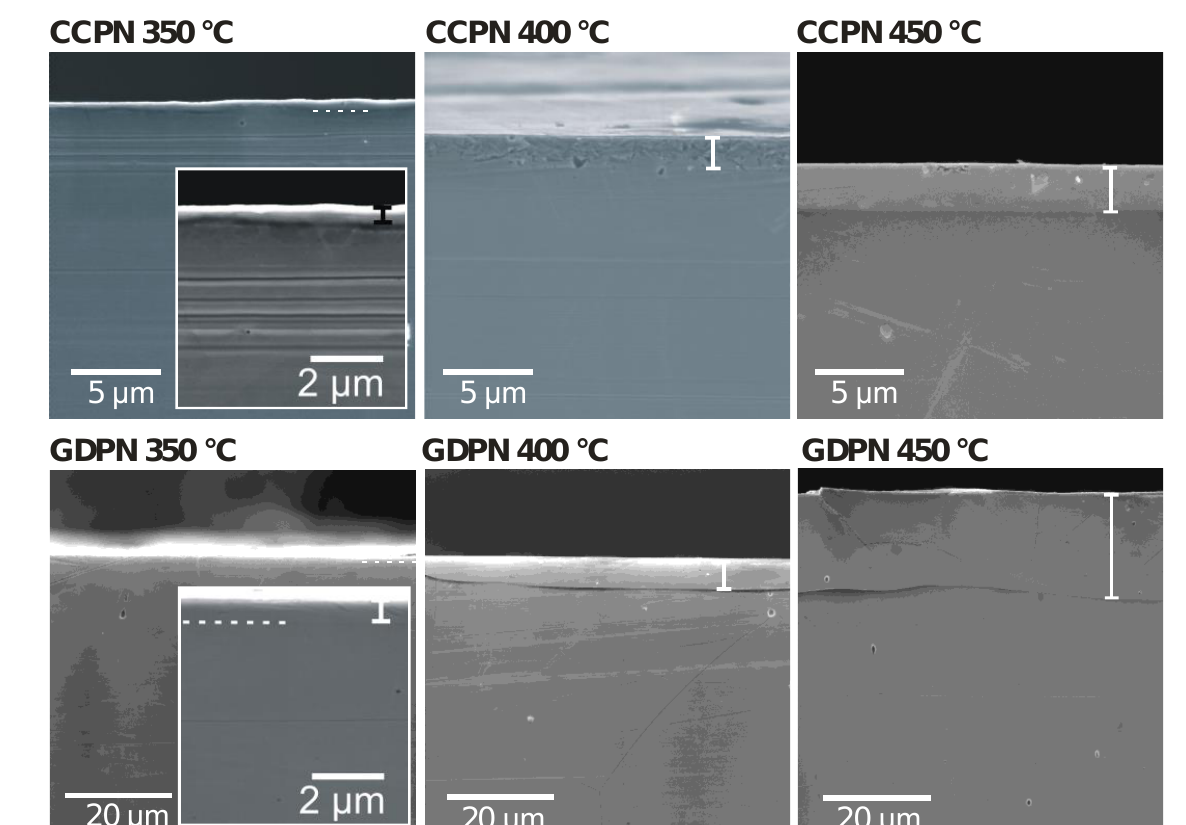
Figure 3. Cross-section SEM images of the plasma-nitrided samples by GDPN and CCPN at the indicated temperatures, etched with Murakami’s reagent. Regions indicated correspond to modified layers produced, respectively.